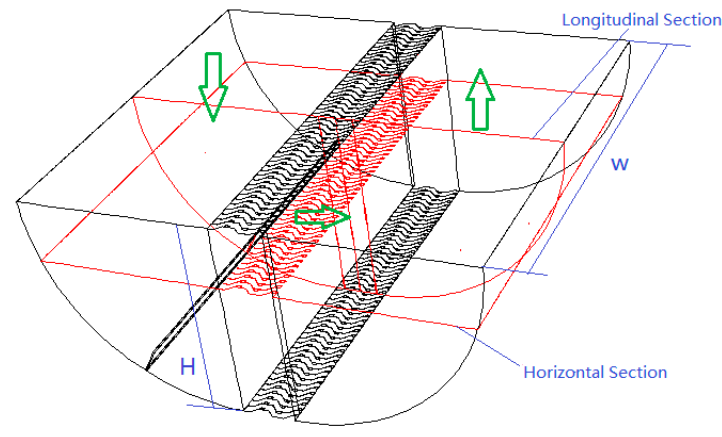
Figure 1. Structure of the studied air–water separator.